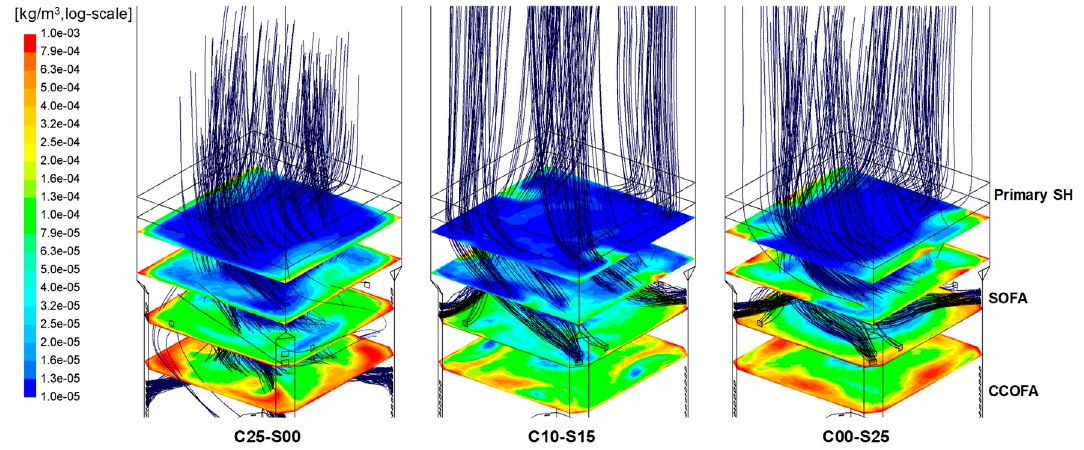
Figure 11. Comparison of NOx emission, UBC in fly ash, and FEGT for different CCOFA/SOFA distributions (total OFA ratio fixed at 25%).